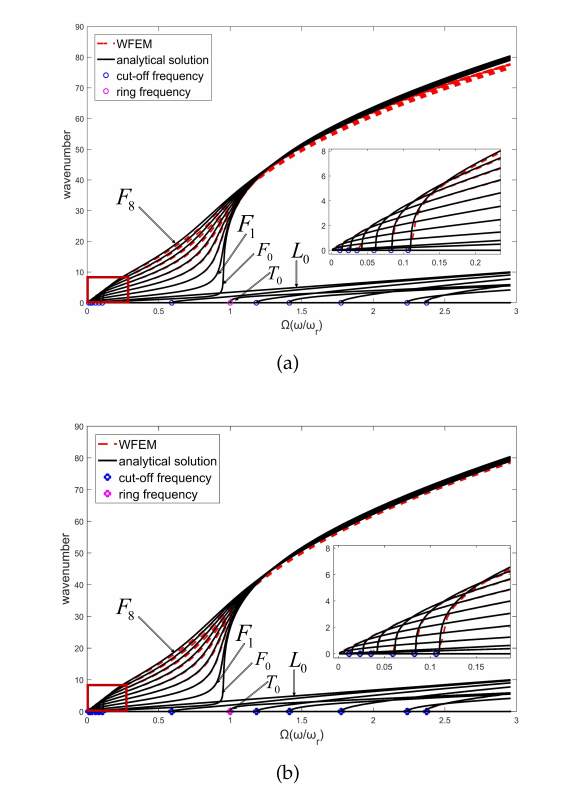
Figure 7. Dispersive curves of a cylinder in axial lengths of ( a ) 0.01 m, and ( b ) 0.005 m, obtained by WFEM and high-order analytical wave equation. The bottom shows longitudinal and torsion waves, and the top shows flexural